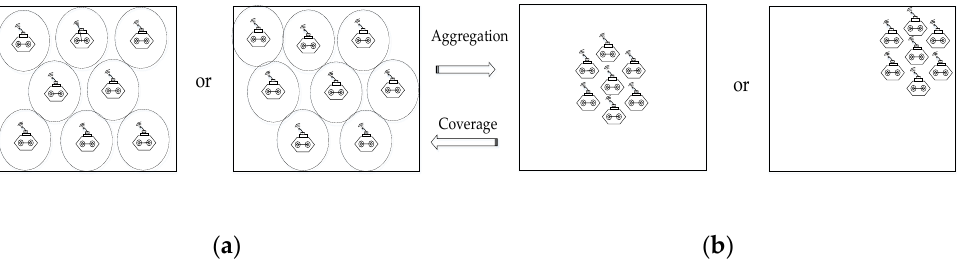
Figure 1. The coverage and aggregation: ( a ) Coverage; ( b ) aggregation.